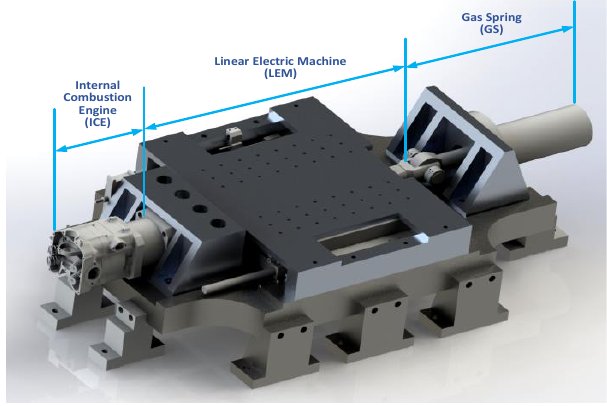
Figure 1. The 3D structure of a FPLG.